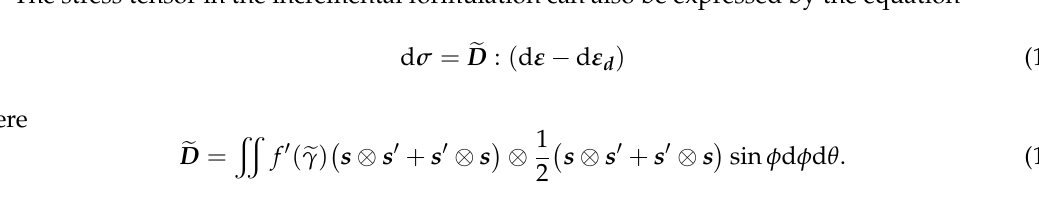
Figure 3. Schematic view of the proposed model.